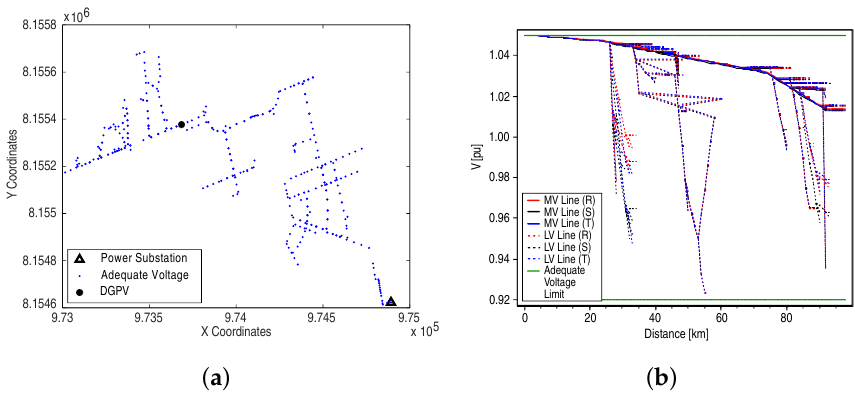
Figure 17. Scenario 4: ( a ) voltage rating after allocation of DGPV and ( b ) voltage profile after allocation of